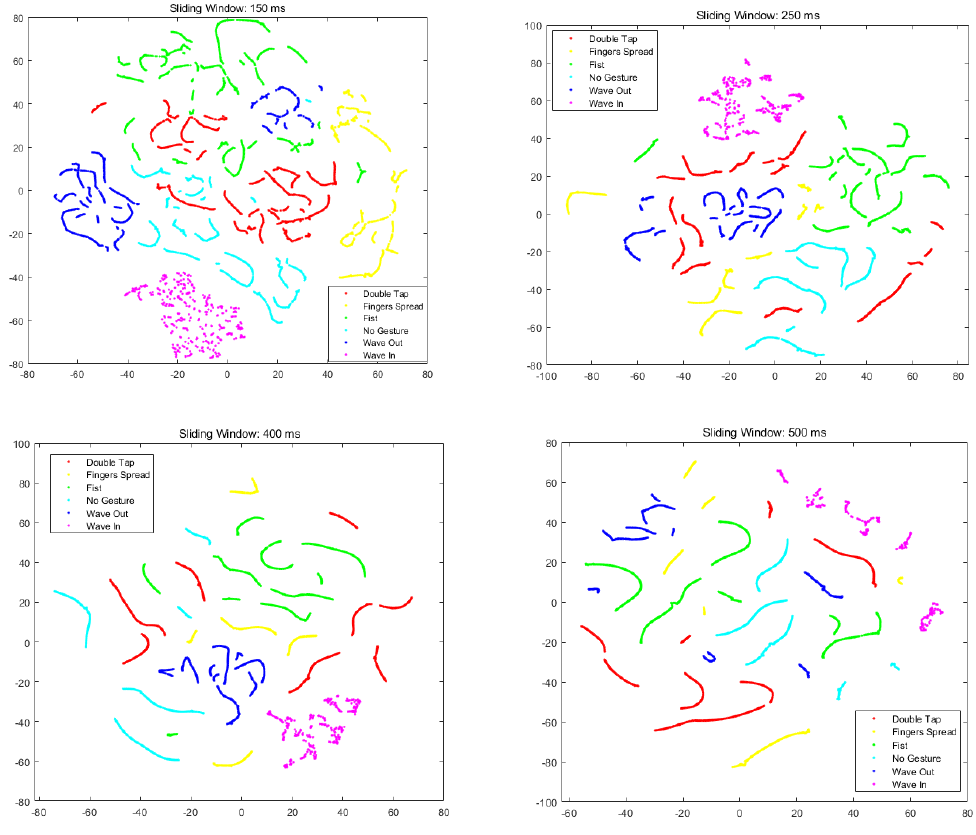
Figure 9. T-distributed stochastic neighbor embedding (t-SNE) results from different sliding window lengths.